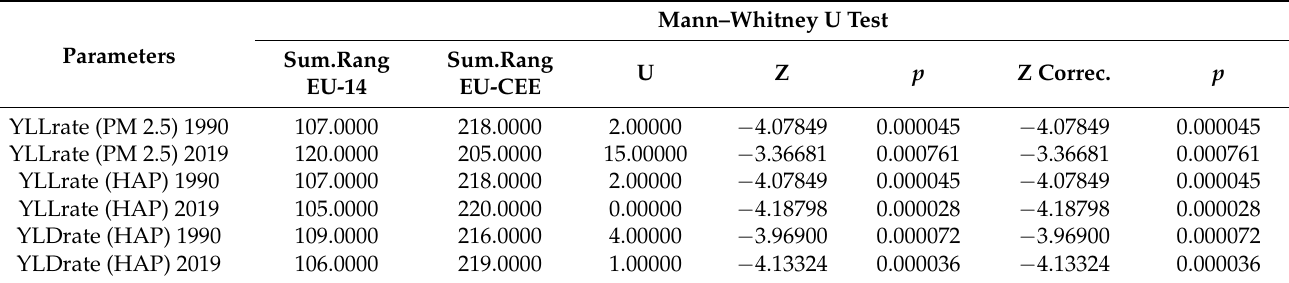
Table 4. Parameters of a non-normal distribution.